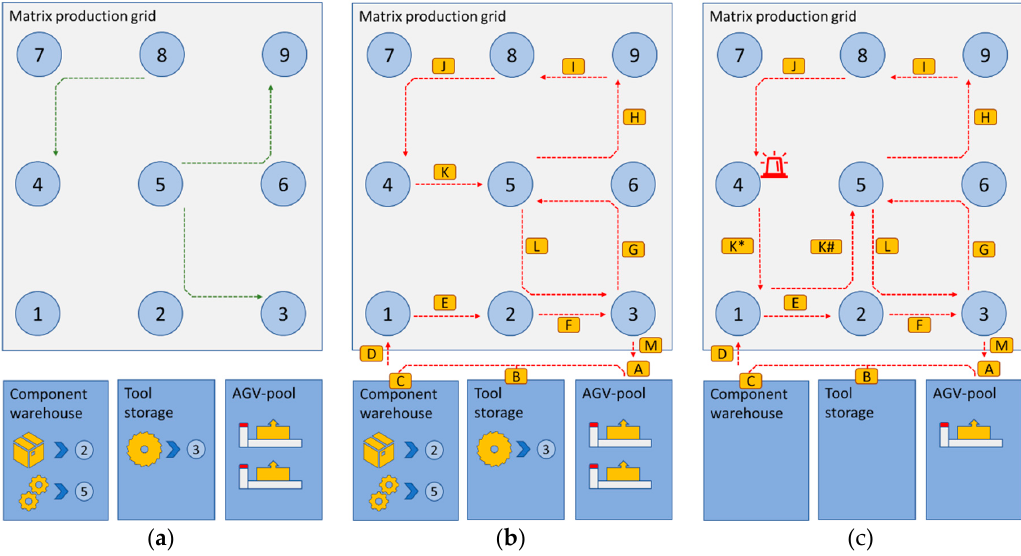
Figure 8. Phases of extended and real-time in-plant supply of matrix production: ( a ) Two AGVs